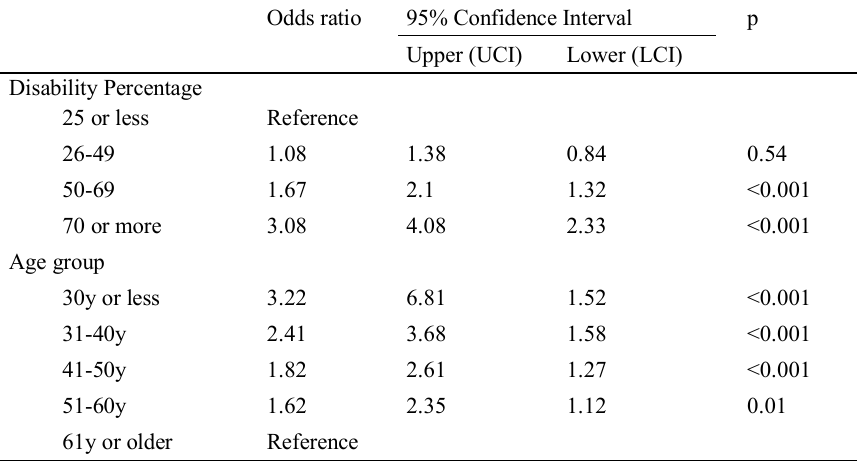
Table 2. Binary logistic regression analysis of sport participation and disability percentage and age.